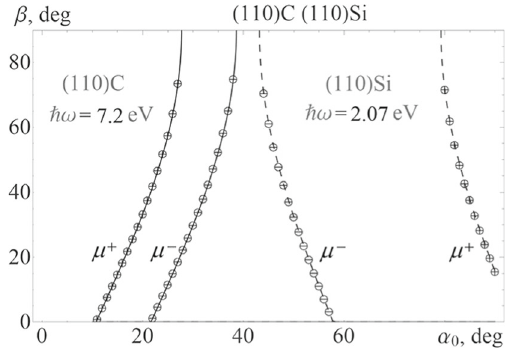
Fig. 10 The emission angle β for ChCR photon of the energy ¯ h ω versus the muons inlet angle α 0 in a